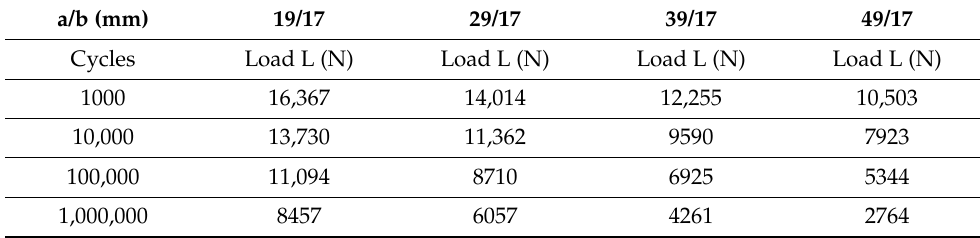
Figure 15. ( a ) Limit load to fatigue by the clamp ( b = 17 mm) determined by the proposed analytical expression as a function of the front lever ( a ) of the clamp and as a function of the number of life cycles; ( b ) relationship between the increase in the value of the front lever ( a ) compared to the shortest front lever ( a = 19 mm). Table 1. Maximum load ( L ) to fatigue failure according to the size of the front clamp lever ( a ) and the number of cycles, for a fixed size of the rear clamp lever (b).